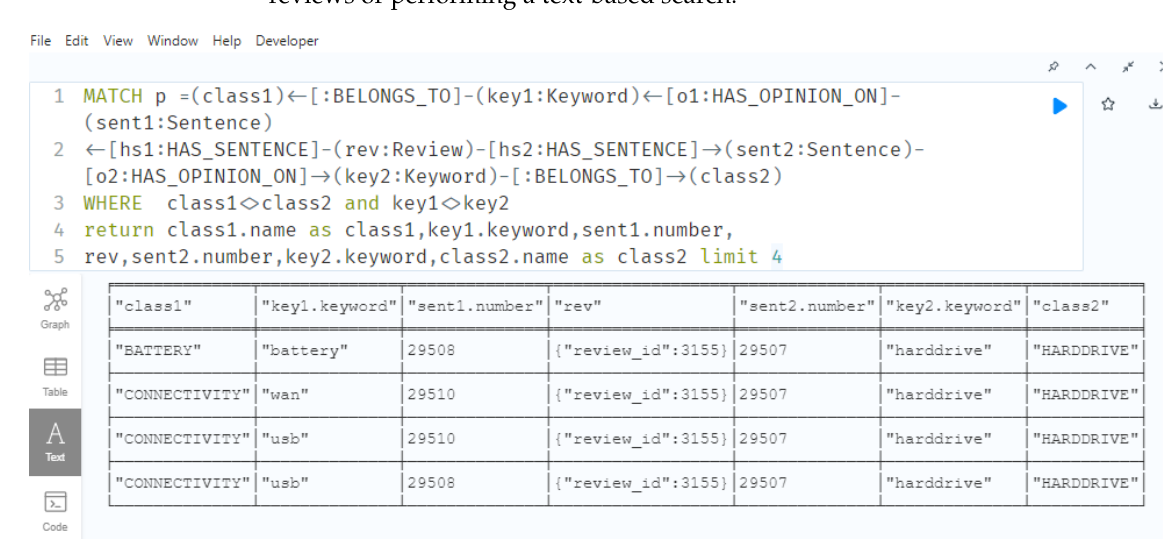
Figure 8. Illustration of data for four bipartite paths at the review level, from review to aspect class. Unipartite projections can then be extracted by extending the paths in two directions (through unique aspect keyword nodes). The individual paths formed can be seen in the